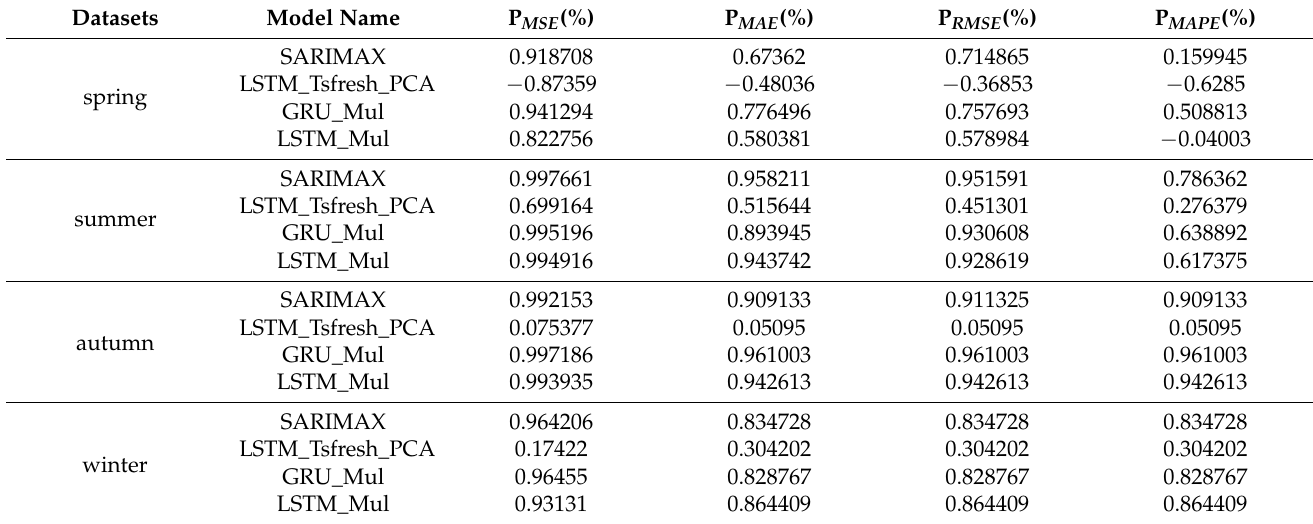
Table 6. Decreasing rates of evaluation metrics of other models and the proposed